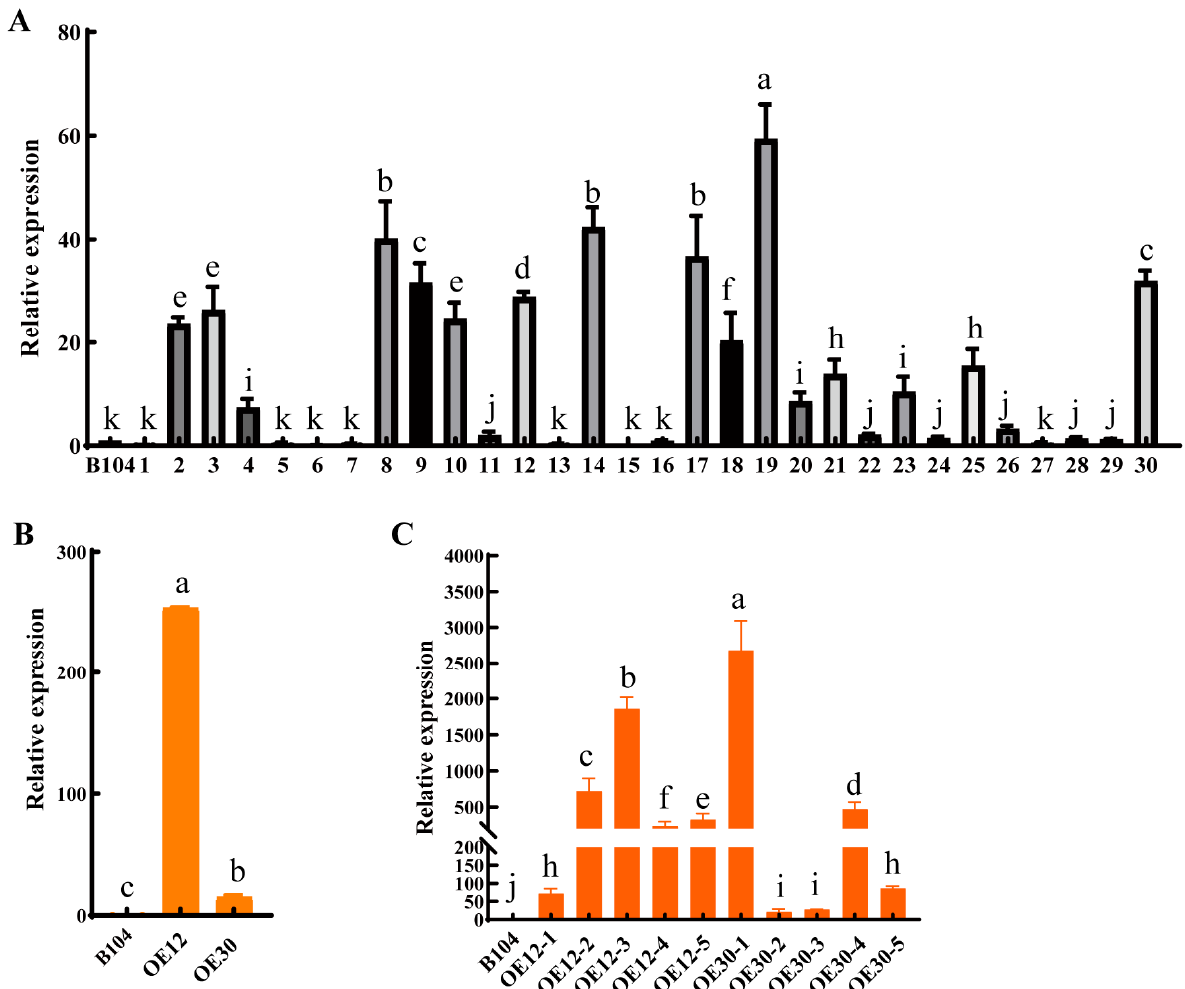
Figure 2. RT-qPCR analysis of the relative expression levels of PCP in overexpression plants. ( A ) T0 leaf at three leaf stage under laboratory conditions. ( B ) T1 leaf at anthesis stage under field conditions. ( C ) T2 pollen at anthesis stage under field conditions. Data represent means ± SD of three biological replicates. Significant differences in expression levels are indicated with different letters ( p < 0.05, one-way ANOVA).